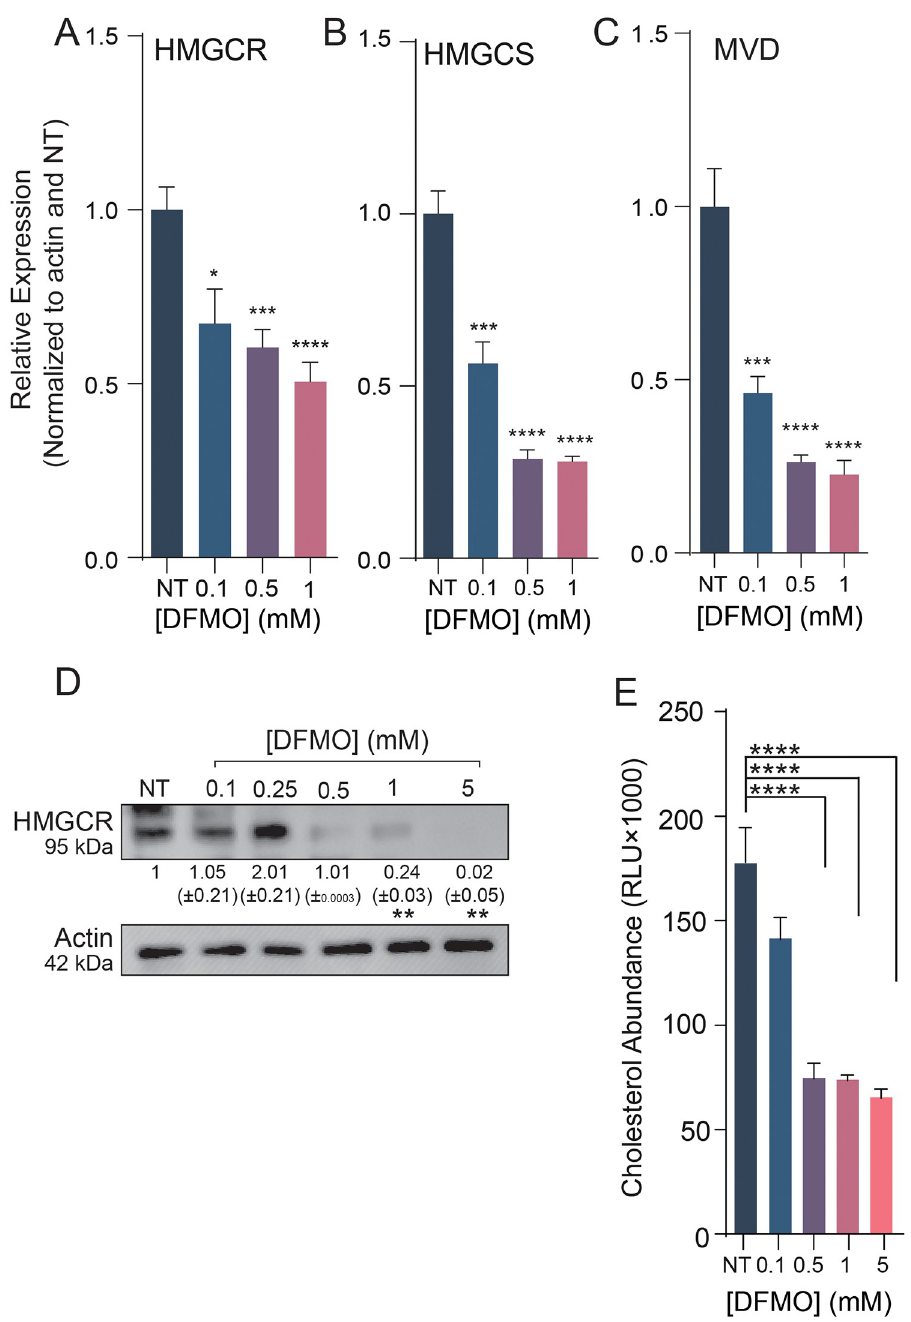
Fig 3. Depletion of polyamines decreases cholesterol synthesis gene expression, translation, and intracellular abundance. (A-C) Normalized qPCR of cholesterol synthesis genes relative to actin expression in Huh7 cells treated with DFMO for 96h. (D) Western blot of Huh7 cells treated with increasing doses of DFMO. Actin was used as a loading control. (E) Intracellular cholesterol abundance in DFMO treated Huh7 cells. * p < 0.05, ** p < 0.01, *** p < 0.001, and **** p < 0.0001 by the Student’s t test. Data from at least three independent experiments. Error bars represent standard error.